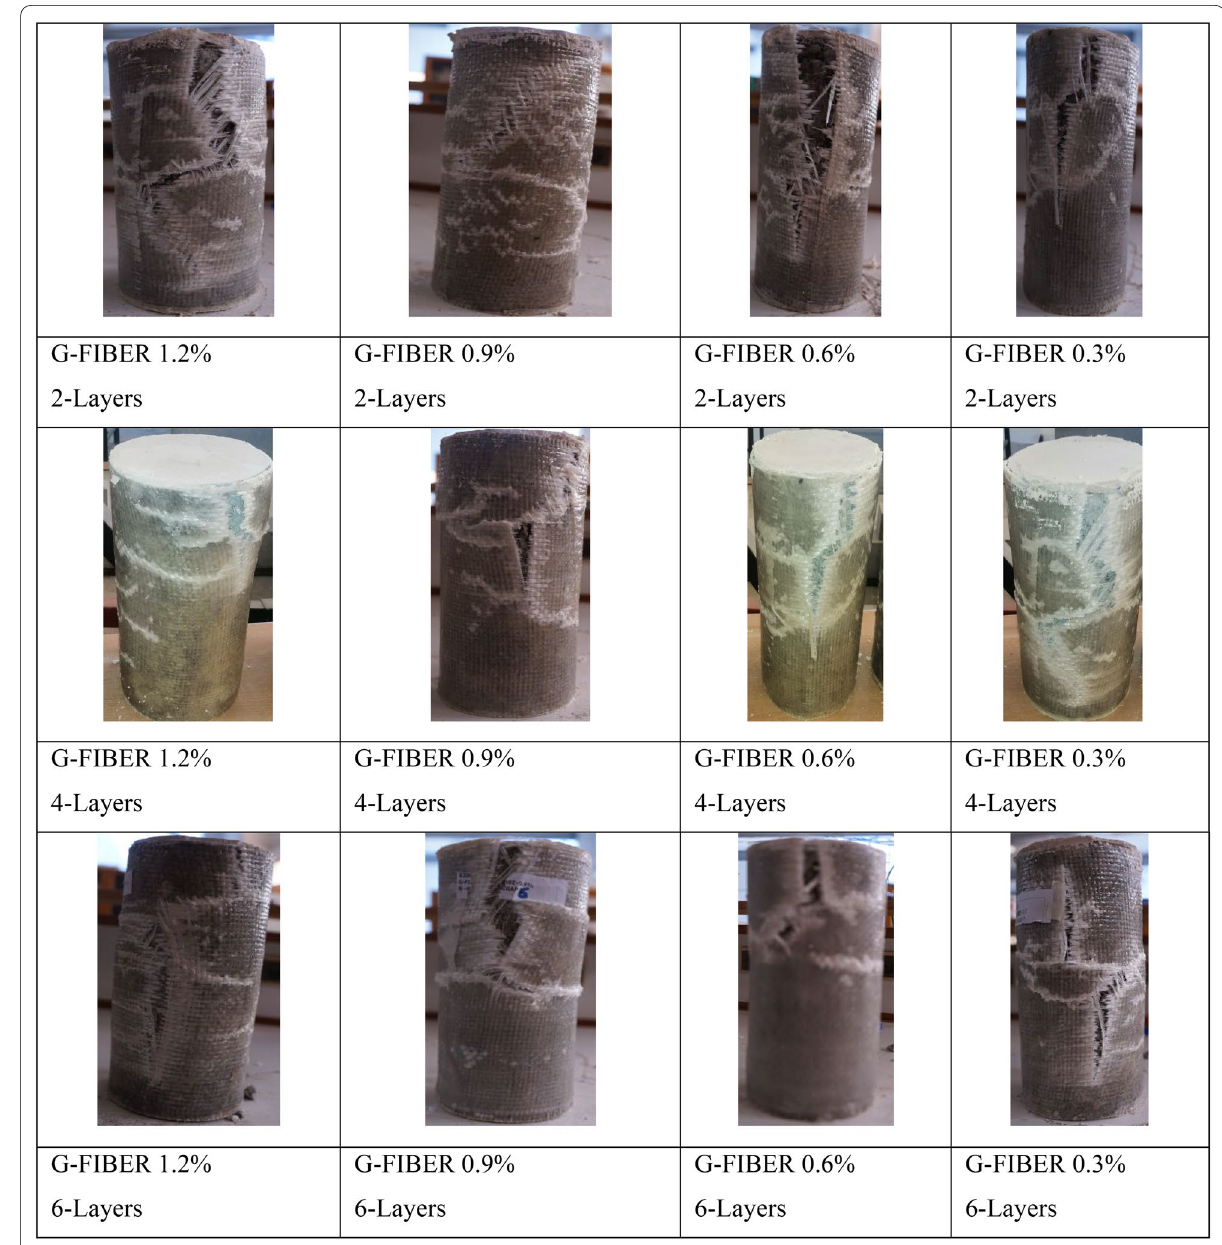
Fig. 8 Typical failure modes of test cylinders (strength concrete